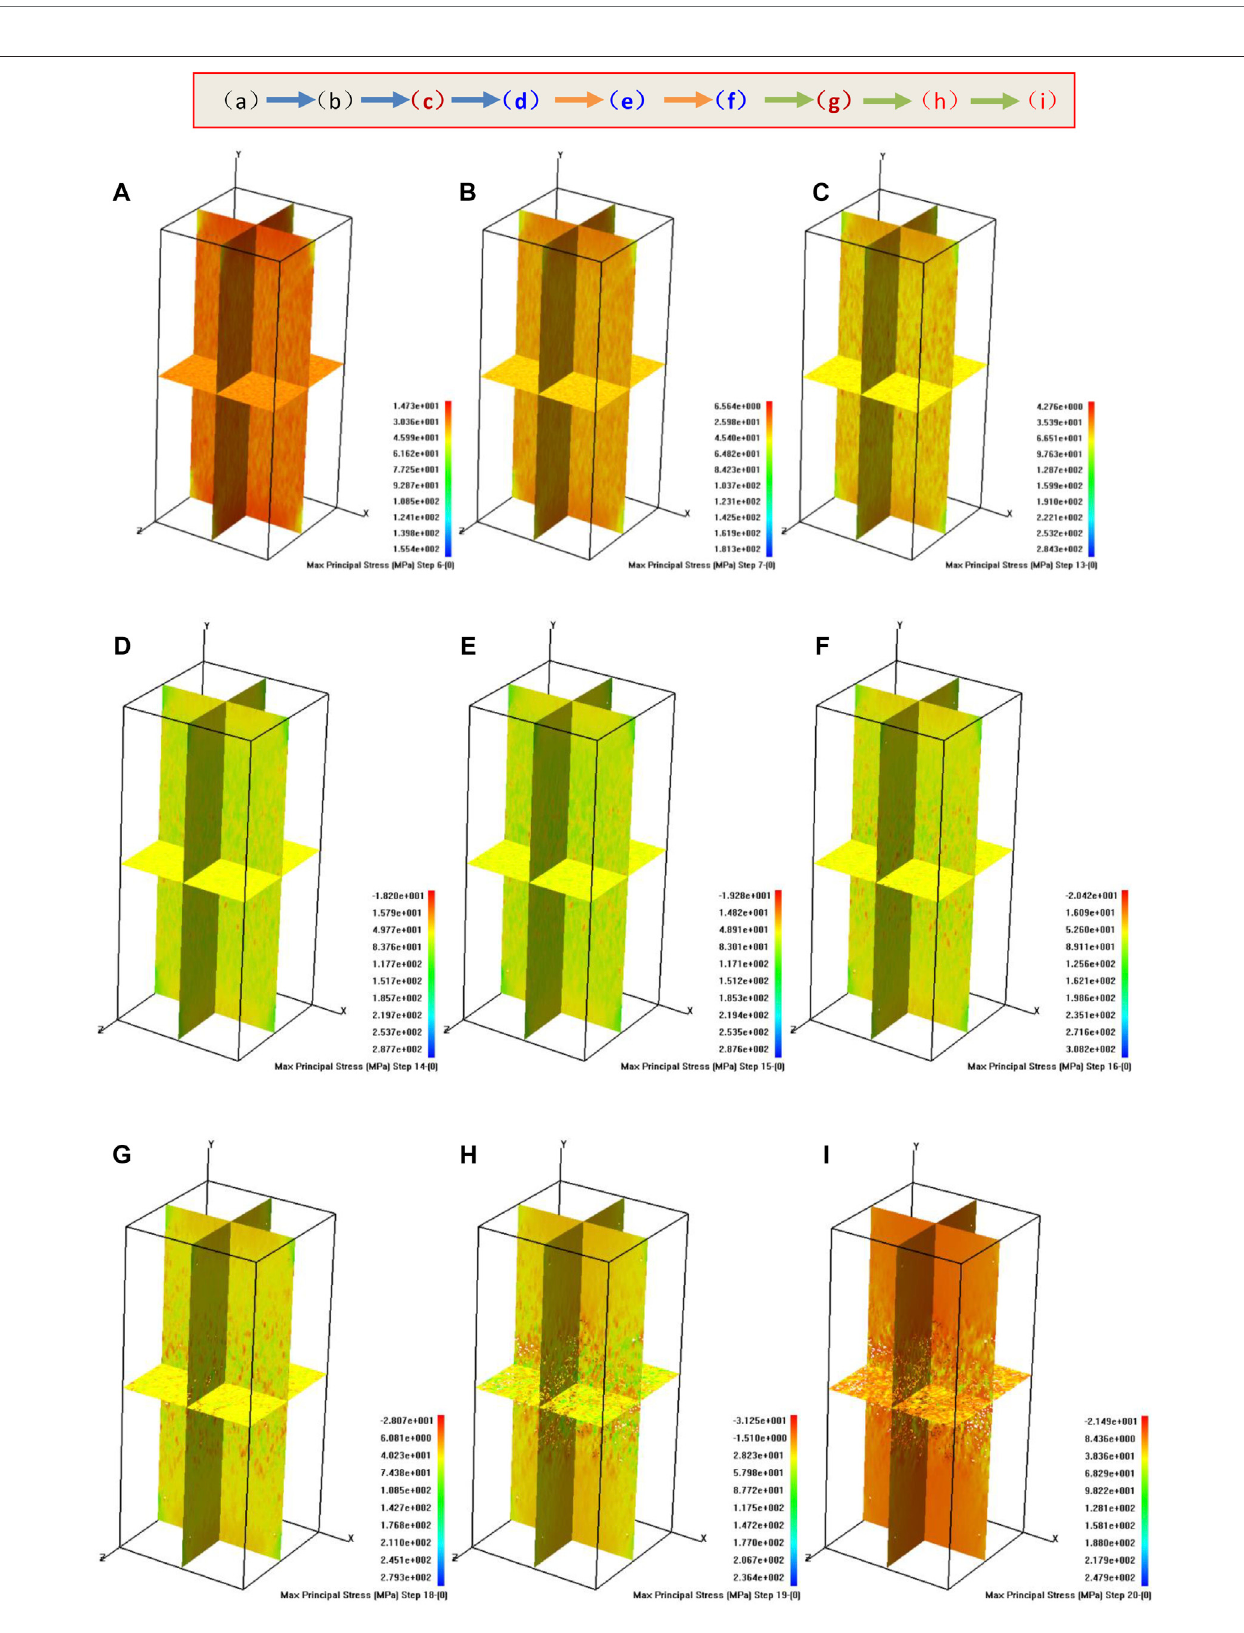
FIGURE 11 | Stress section under the loading rate of 0.00001 mm/s.